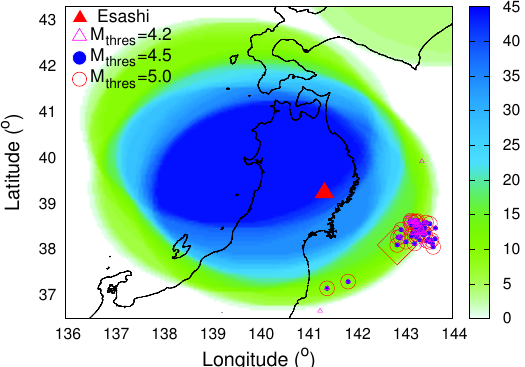
Figure 7. Estimating the M 9 Tohoku EQ epicenter: Color contours of the number of the small areas exhibiting the minimum of the fluctuations of κ 1 almost simultaneous with that in the entire Japanese region. The red diamond depicts the M 9 Tohoku EQ epicenter and the red triangle the location of the Esashi measuring magnetic station (the other measuring station, Mizusawa, lies only a few tens of km away from Esashi). The epicenters of the EQs that occurred within the candidate epicentral area (blue-green) after 5 January 2011 and before the M 9 Tohoku EQ for various magnitude thresholds M thres are also shown. Taken from Ref. [64].